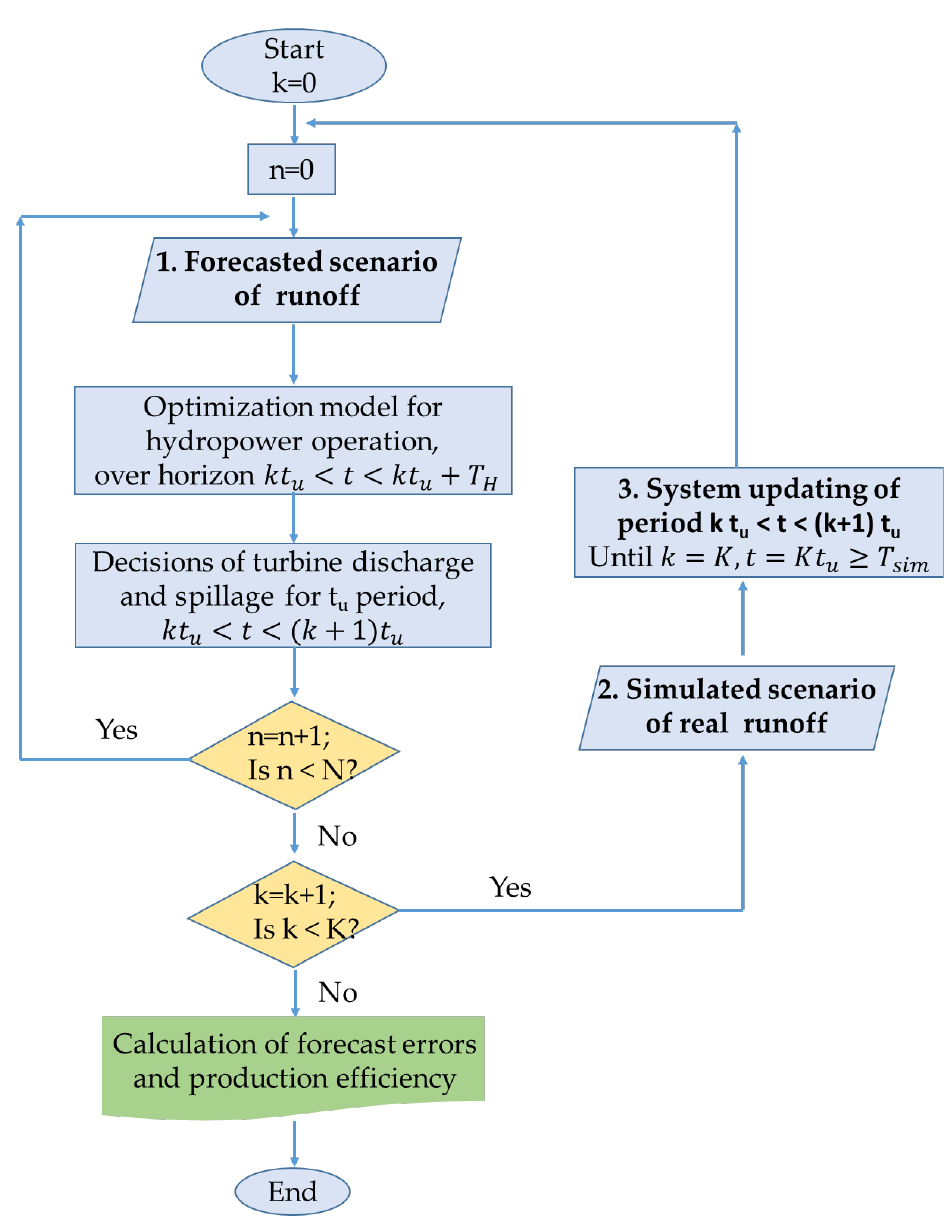
Figure 1. Flowchart of the model framework.